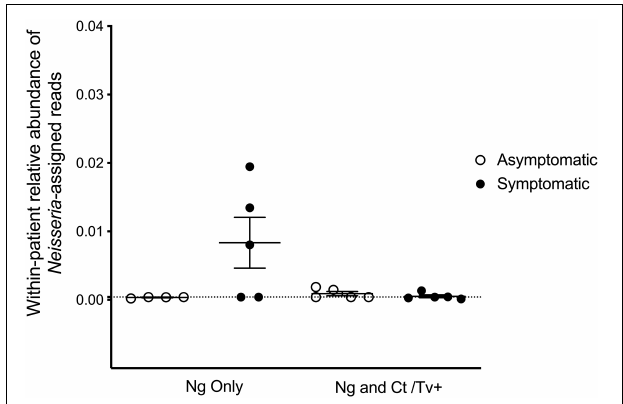
FIGURE 1 | Reads assigned to the Neisseria genus comprise a small proportion of the cervicovaginal microbial community. We characterized the genital microbial communities of 19 females with clinically confirmed gonorrhea using 16S amplicon deep sequencing and microbiome analysis with QIIME. After demultiplexing and eliminating low-quality reads, 100,216 reads were retained for downstream analyses (mean number of reads per sample = 5,274; range = 2,470–9,528 reads). Neisseria -assigned 16S ribosomal RNA gene reads made up only 0.24% of all reads in the dataset and are plotted for each individual’s microbial community. No significant differences in relative abundance of 16S reads from Neisseria spp. between any group was observed using one-way ANOVA with Tukey’s correction for multiple